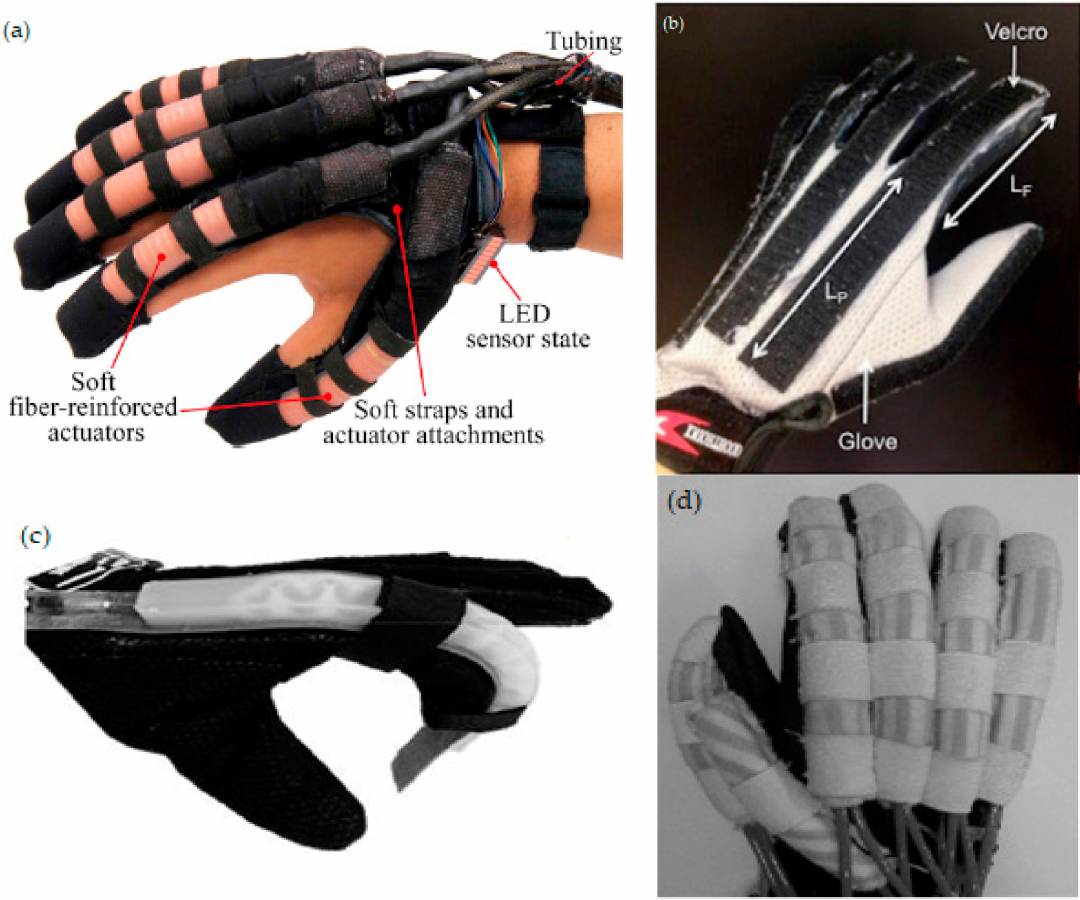
Figure 3. Different actuation mechanisms for soft robotic hand exoskeletons. ( a ) The Harvard Glove 2.0 with fiber-reinforced actuators with fiber-reinforced actuators and light-emitting diode (LED) sensor display. Reprinted from [6] with permission from Elsevier. ( b ) The NUS prototype glove with fabric as the strain limiting layer. Reprinted from [10] with permission from Taylor & Francis. ( c ) The NUS glove for rehabilitation. Reprinted from [17] with permission from Springer Nature. ( d ) The Power-Assist glove. Reprinted from [38] with permission from Fuji Technology Press